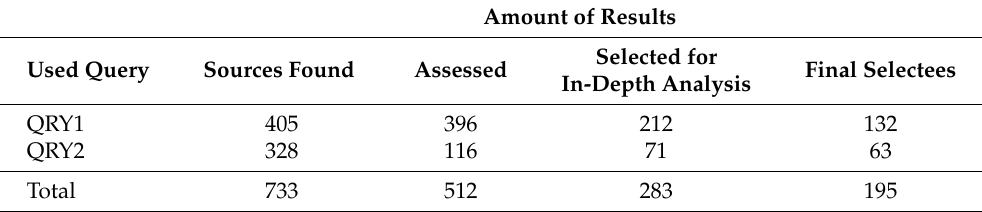
Table 1. Sources searched for years 2017–2022 (including articles up to 30 January